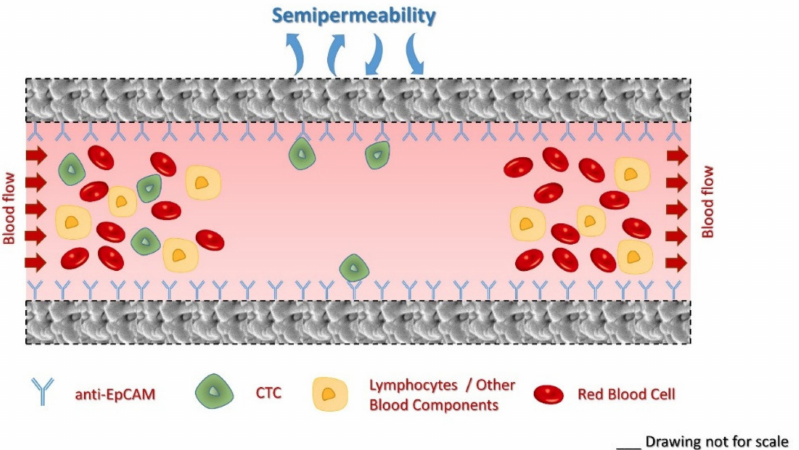
Figure 1. Schematic representation of the simultaneous CTC capture and hemodialysis processes.